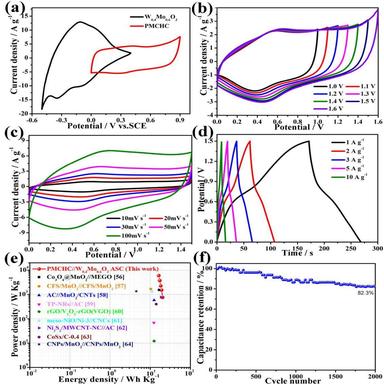
(a) Comparative CV curves of the W0.4Mo0.6O3 nanoneedle arrays and PMCHC, tested in a three-electrode configuration at 30 mV s1 , (b) The CV curves of ASC with various potential ranges at 30 mV s1 , (c) The CV curves of the ASC at different scan rates, (d) The galvanostatic charge/discharge curves of the ASC at various current densities, (e) The Ragone plots related to energy and power densities of the ASC, (f) Cycling tests showing a better stability of the ASC after 2000 charging and discharging cycles.